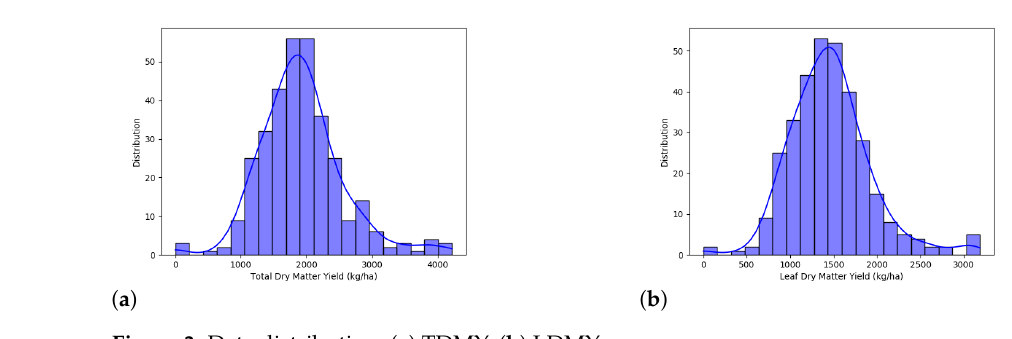
Figure 3. Data distribution. ( a ) TDMY; ( b ) LDMY.